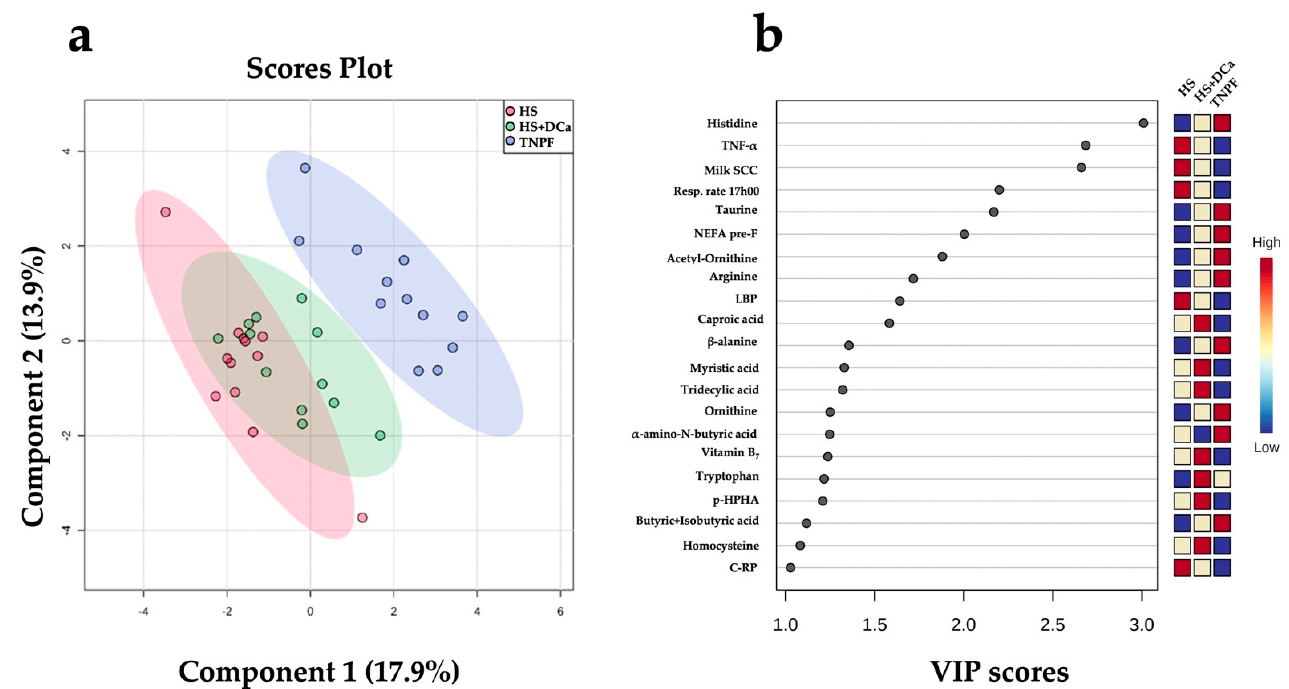
Figure 3. Discriminant analysis of fecal metabolites of dairy cows following heat stress (HS), heat stress with vitamin D 3 and Ca (HS+DCa), or pair feeding in thermoneutrality (TNPF). ( a ) Two- dimensional partial least squares discriminant (PLS-DA) score plot. ( b ) Variable importance projec- tion (VIP) scores analysis based on component 1 of the PLS-DA used to rank the relative contribution of metabolites to the variance between dietary treatments. Treatments were: (1) heat stress (HS); (2) heat stress with higher vitamin D 3 and Ca (HS+DCa; 1820 IU/kg and 1.5% Ca); (3) thermoneutral, pair-feeding (TNPF). Fecal metabolites data were obtained using a LC–MS/MS custom assay. Fecal metabolite data were obtained using an LC–MS/MS custom assay. p-HPHA = plasma p- hydroxyphenilacetic acid; C-RP = plasma C-reactive protein.